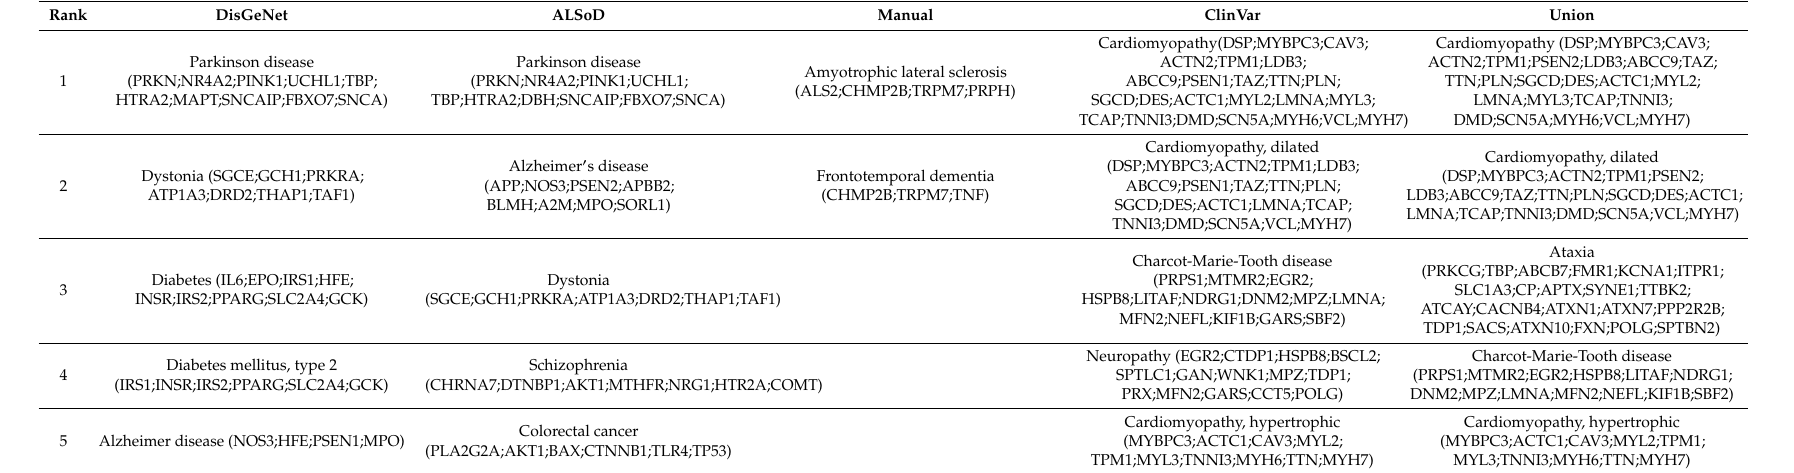
Table 4. Top 5 most enriched human diseases in Enrichr analysis based on the OMIM disease database for each set of predicted ALS-linked genes. Overlapping genes are between brackets. Only diseases significant at adjusted p -value < 0.05 are